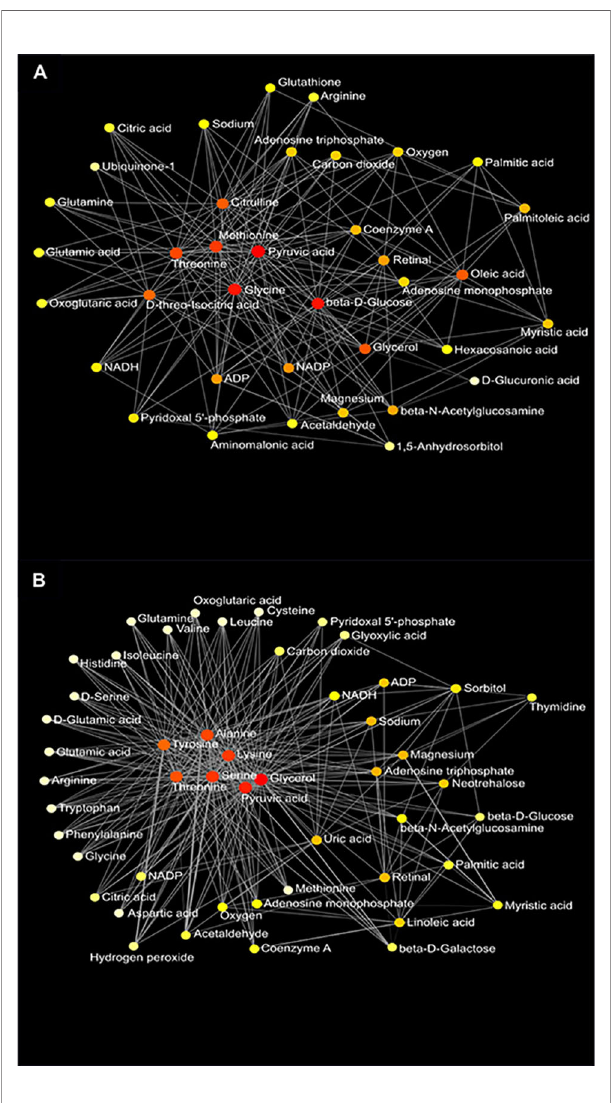
FIGURE 8 | Metabolic network of plasma metabolites between the AIN93G and high-fat diet (A) and between wild-type and Mcp-1 -/- mice (B) . Colors, from white-yellow to red, indicate levels of impact the metabolites have on the network in an ascending order (the number of connections a node has to other nodes and the number of shortest paths going through the node). Network statistics for (A, B) are presented in Supplementary Table 3